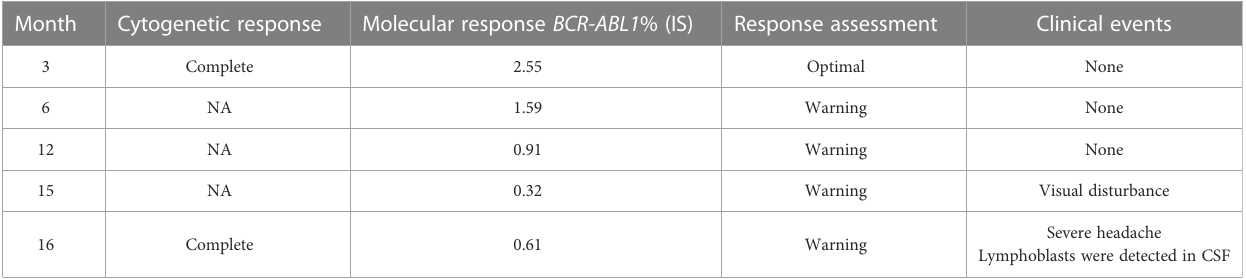
TABLE 1 Cytogenetic and molecular response after dasatinib therapy according to ELN guidelines (4). Month Cytogenetic response Molecular response BCR-ABL1 %